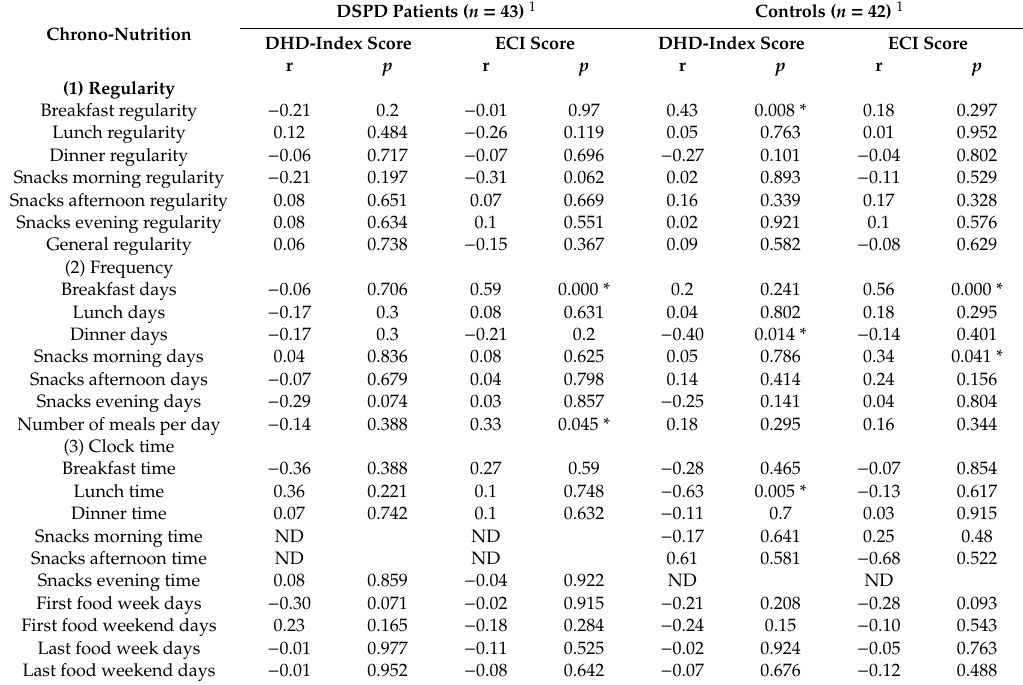
Table 4. Correlation between chrono-nutrition and diet quality in DSPD patients compared with controls. Spearman’s partial correlation adjusted for sex, age, education, BMI and disorders). Chrono-Nutrition